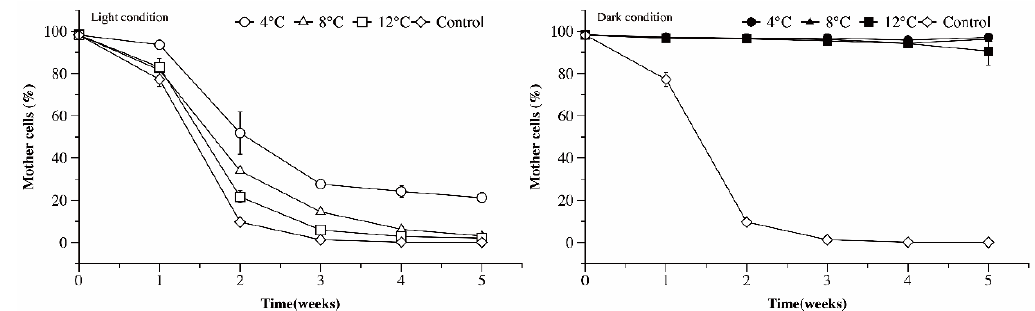
Figure 4. The ratio of mother cells to the sum of mother cells and daughter cells under different temperature and light conditions, as a function of time.